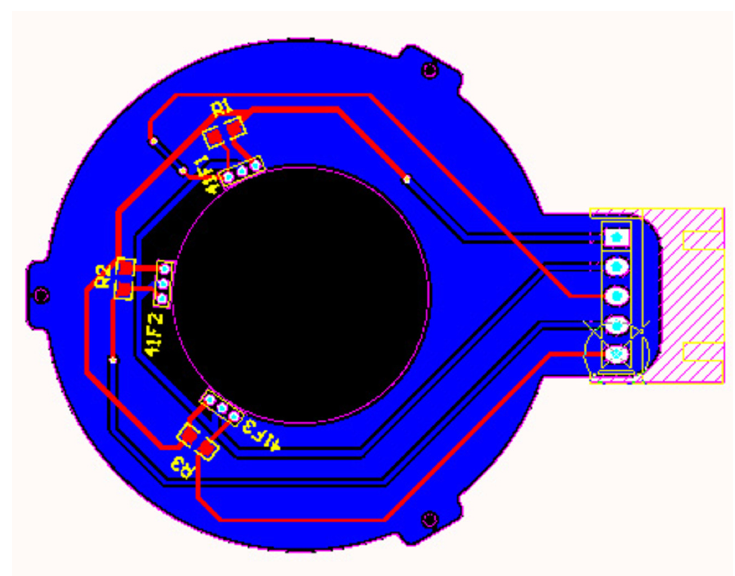
Figure 2. Hall sensor board designed by Altium